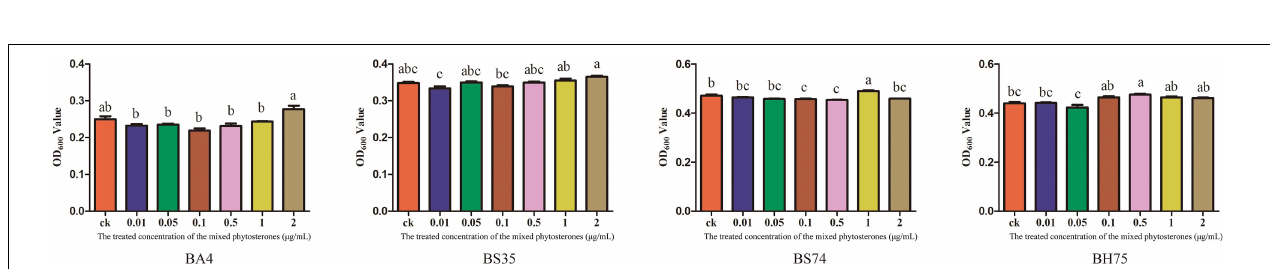
FIGURE 5 | Quantification of total bacteria, total fungi, and specific microbes (including Bacillus , Pseudomonas , Burkholderia , and Fusarium ) in different soil samples. Small letters in figures show significant differences determined by Tukey’s test ( p ≤ 0.05, n = 3).